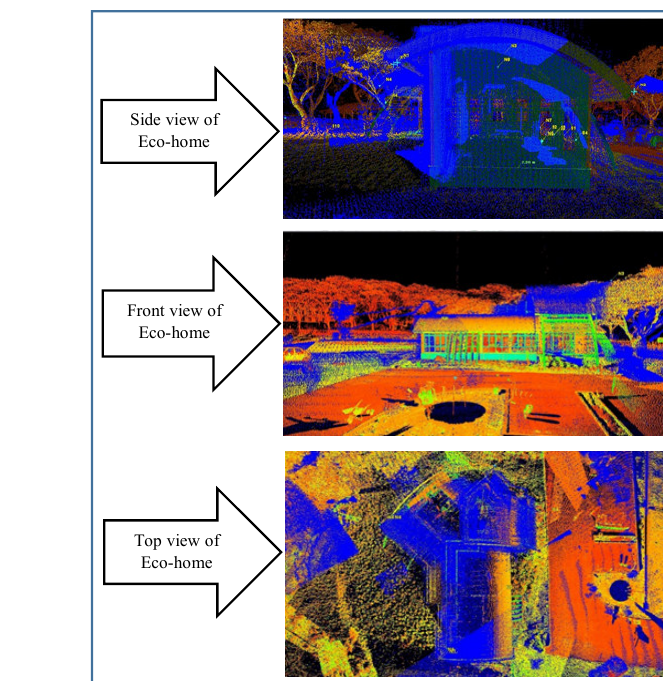
Figure 11. The integration process for ALS and TLS dataset using man-made registration method.